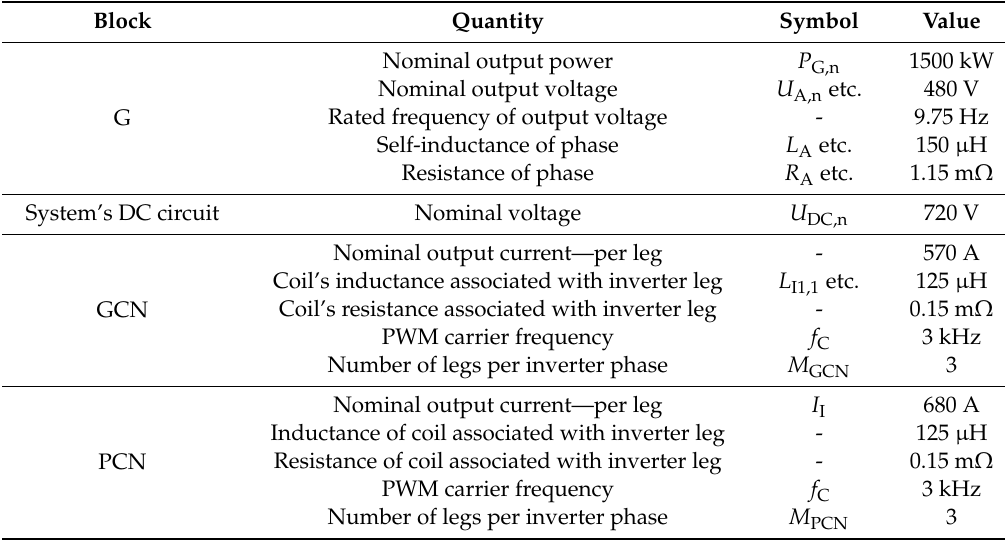
Table 2. Parameters of the MSS for simulation